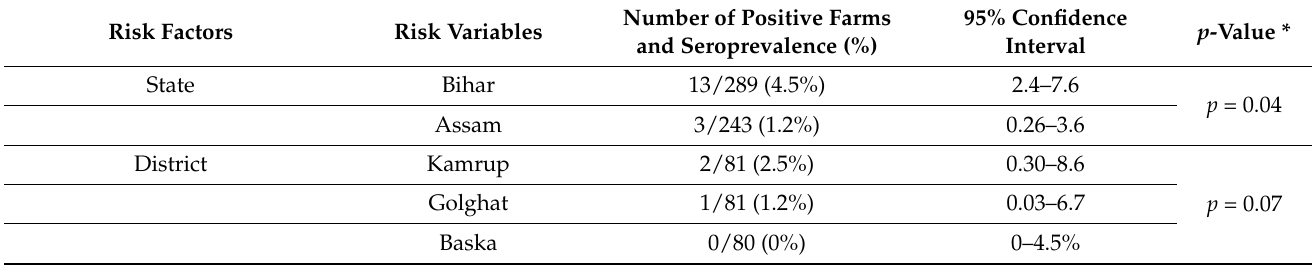
Table 1. Univariable analysis for risk factors associated with L. serovar Hardjo farm seroprevalence at p < 0.1. Risk